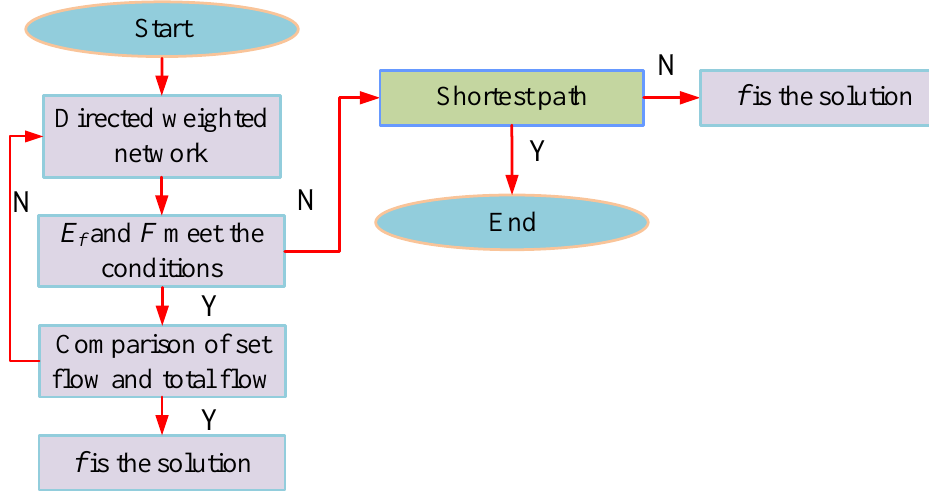
Figure 5. Specific steps of BG iterative algorithm.